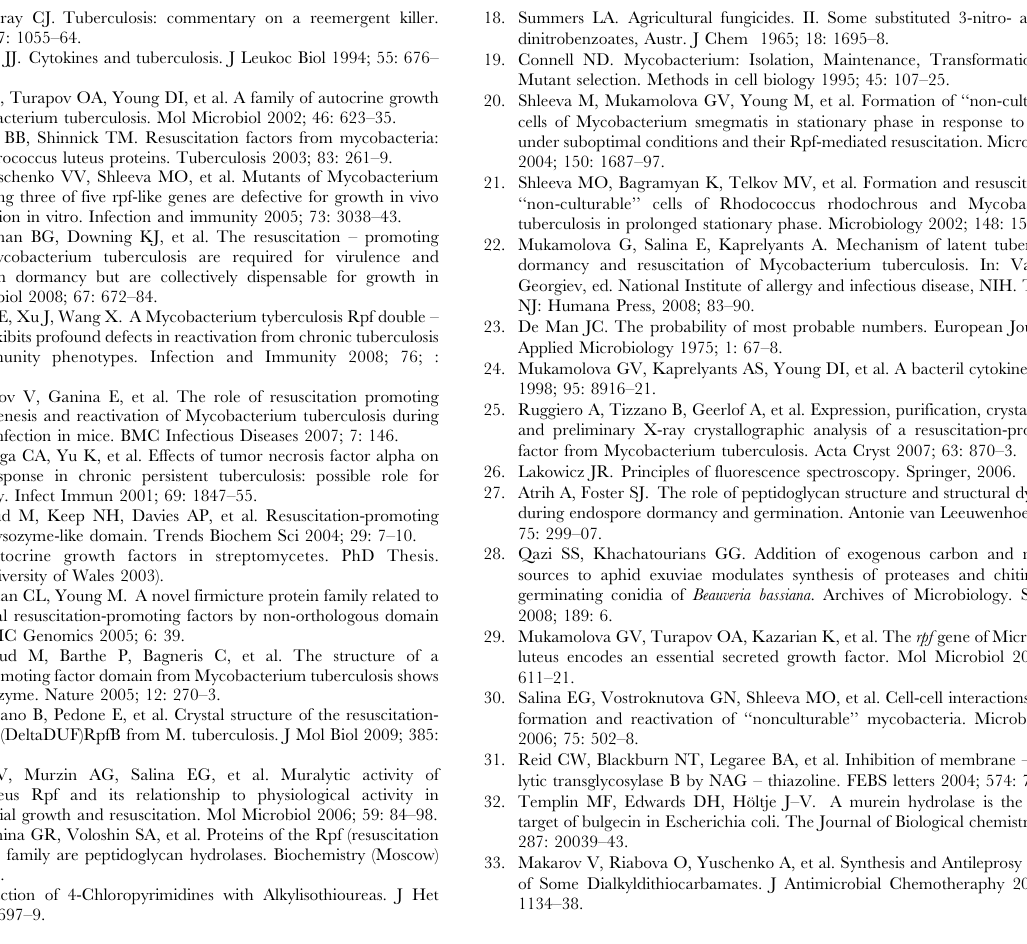
limits (95%) for MPN are shown. These numbers present logarithmic transformation of cell concentration (cells/ml) esti- mated by MPN assay. The ‘‘lower ‘‘ and ‘‘upper’’ values are logarithmic transformation of cell concentrations representing 95% confidence limits of the assay.